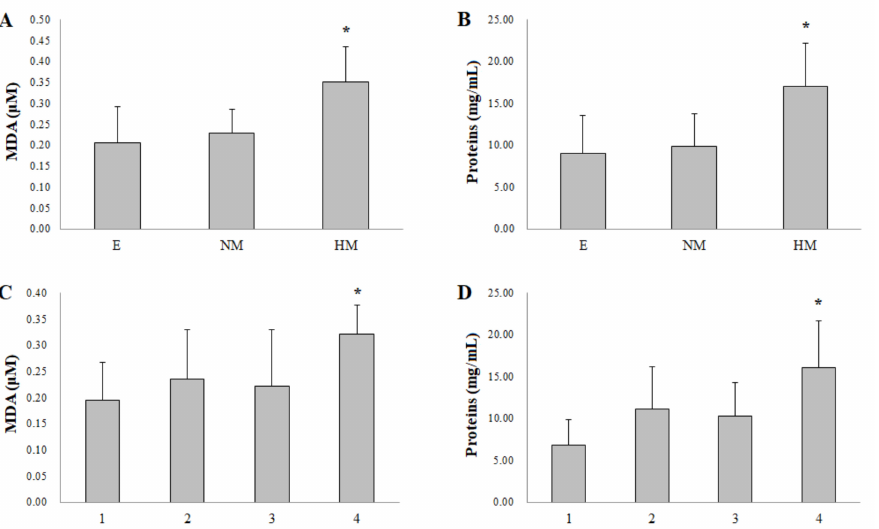
Figure 2. Oxidative stress parameter malondialdehyde (MDA) and protein concentration in the collected subretinal fluid. ( A , B ), comparison among the three refractive groups: E: emmetropics ( n = 43); LM: Low myopic ( n = 13); and HM: High myopic ( n = 9). * p < 0.01 vs. the E group. ( C , D ), comparison by retinal detachment extension (in number of quadrants). * p < 0.01 vs. 1